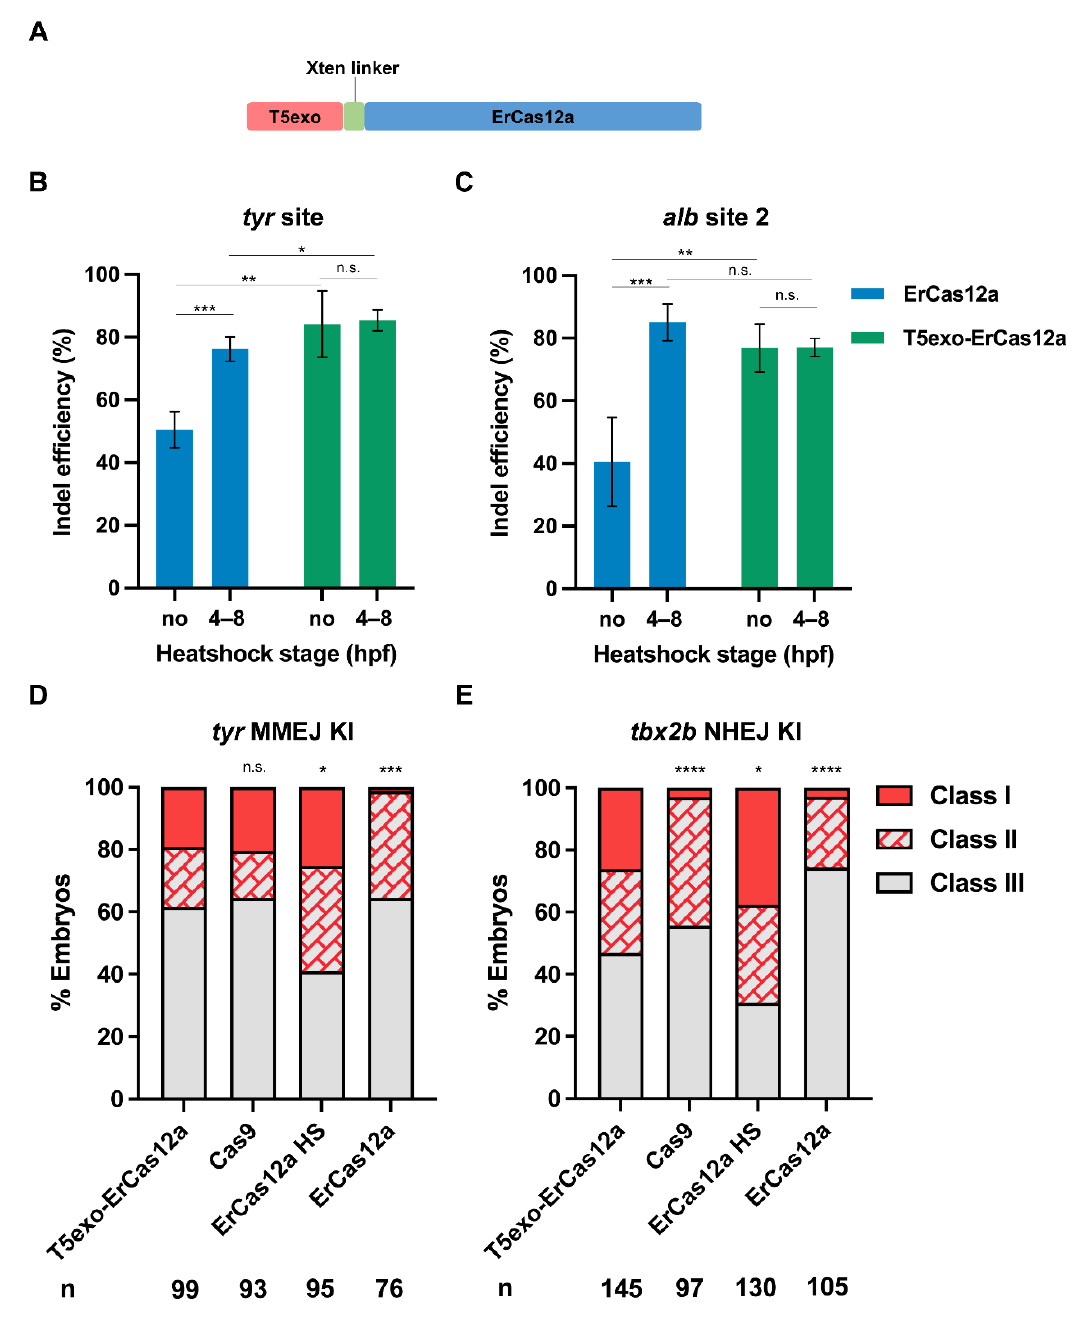
Figure 5. T5exo-ErCas12a efficiently mediates heatshock-free indel mutation and large fragment knockin. ( A ) Schematic diagram of ErCas12a fused with T5 exonuclease at the N-terminus. The two proteins are separated by an Xten linker. ( B ) Indel efficiency in embryos injected with T5exo-ErCas12a mRNA and tyr pre-crRNA under heatshock or non-heatshock conditions. The results were compared with ErCas12a mRNA injection under the same conditions. ( C ) Indel efficiency in embryos injected with T5exo-ErCas12a mRNA and alb pre-crRNA2 under heatshock or non-heatshock conditions. The results were compared with ErCas12a mRNA injection under the same conditions. Data in ( B , C ) represent mean ± s.d. of at least three independent replicates. Unpaired two-tailed Student’s t -test was used to calculate p values (* p < 0.05; ** p < 0.01; *** p < 0.001; “n.s.” indicates the difference is not significant). ( D ) Evaluation of MMEJ-based knockin efficiency by the proportion of broad (Class I) and sparse (Class II) fluorescence-positive embryos injected with T5exo-ErCas12a, Cas9, or ErCas12a (with and without heatshock) systems at the tyr locus. Representative images of different expression patterns are shown in Figure 1D. HS: Heatshock. ( E )